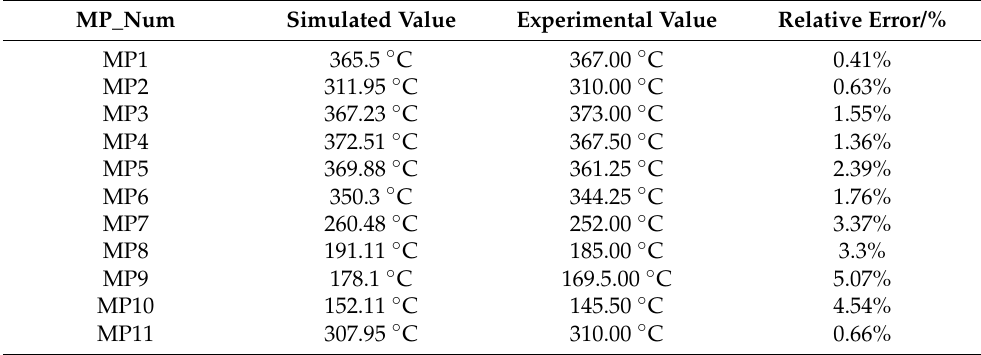
Figure 10. Temperature distribution of the uncoated piston. Table 6. Comparison between the simulated results and measured results at the max torque